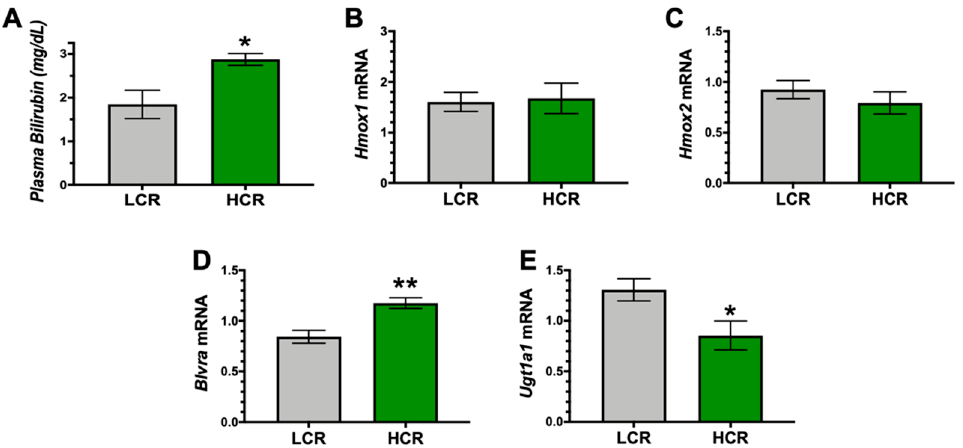
Figure 3. Plasma bilirubin and hepatic heme oxygenase pathway in LCR and HCR rats. ( A ) Plasma bilirubin levels. ( B ) Hepatic heme oxygense-1 ( Hmox1 ) mRNA levels. ( C ) Hepatic heme oxygenase-2 ( Hmox2 ) mRNA levels. ( D ) Hepatic biliverdin reductase-A ( Blvra ) mRNA levels. ( E ) Hepatic UDP Glucuronosyltransferase Family 1 Member A1 ( Ugt1a1 ). * p < 0.05 as compared to LCR rats. ** p < 0.001 as compared to LCR rats. n = 9/group.